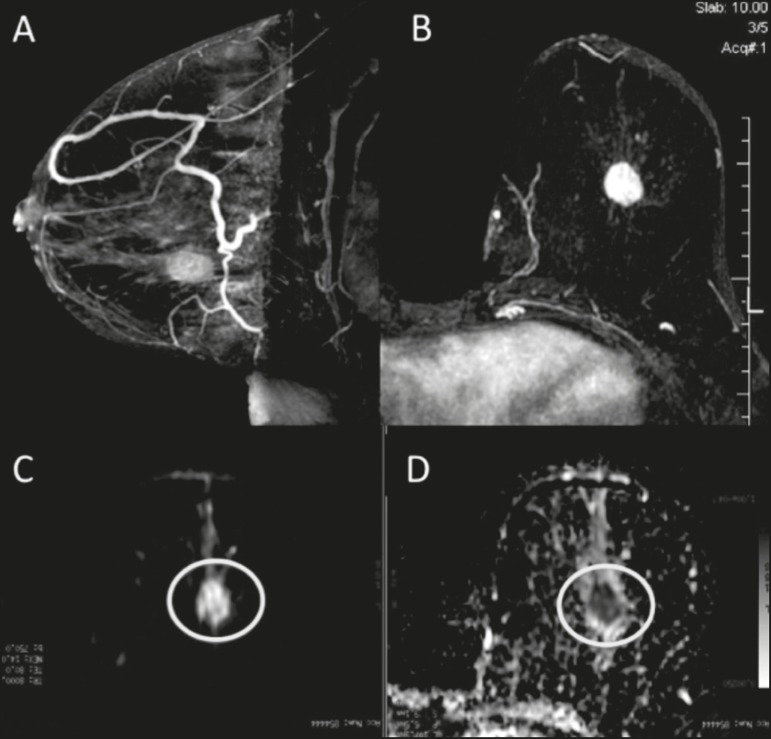
A 64-year-old woman with a nodule in the left breast. Maximum intensity
projection reconstructions of the post-contrast subtraction sequence in
the sagittal and axial planes (A and B, respectively), showing a
circumscribed nodule with heterogeneous enhancement, which presented
high signal intensity in the DWI sequence (C) and low signal intensity
on the ADC map (D), with an ADC value of 0.74 × 10−3
mm2/s. The histological findings were consistent with a
diagnosis of invasive carcinoma of non-special type.